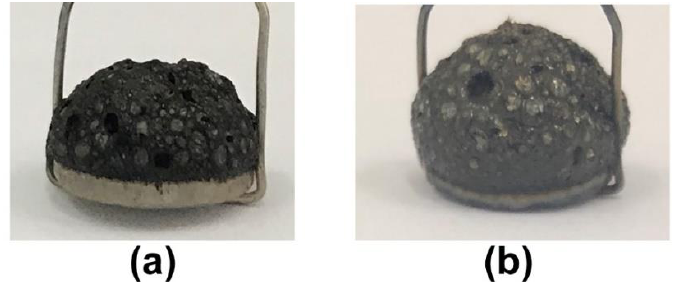
Figure 5. Intumescent char from ( a ): sodium phenolate; ( b ) sodium p -cresolate.